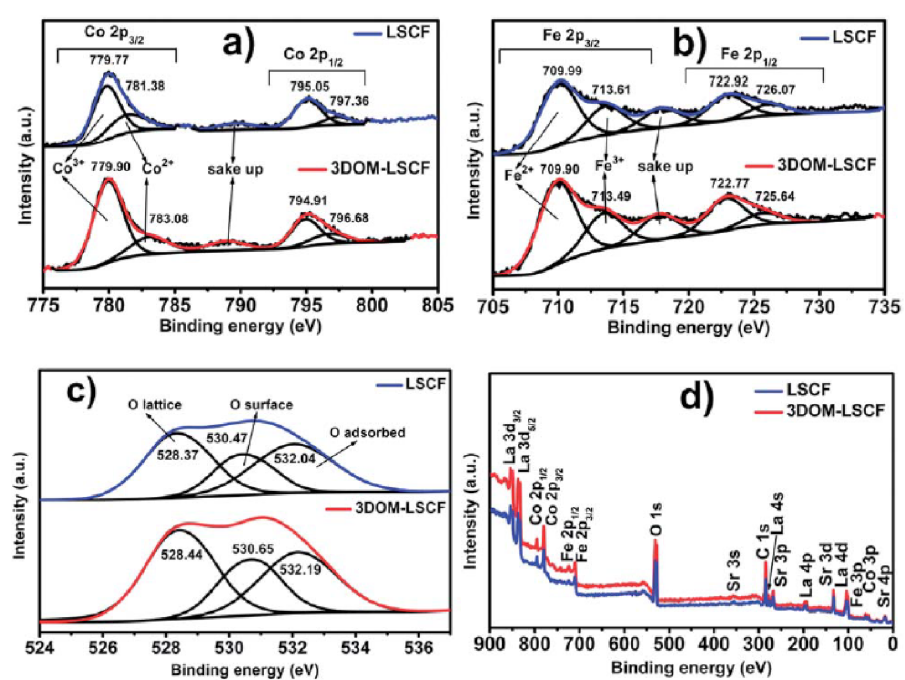
Figure 6. The XPS spectra of ( a ) Co 2p, ( b ) Fe 2p ( c ) and O 1s and ( d ) XPS survey spectra of the double perovskites LSCF and 3DOM-LSCF (Reproduced from Ref. [38] with permission from the Royal Society of Chemistry